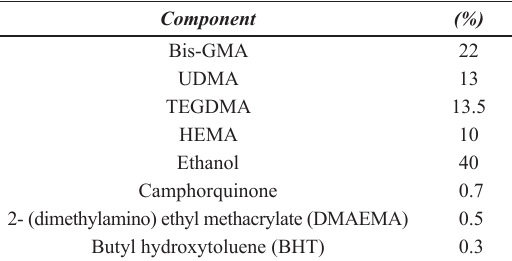
Table 1. Standardized composition of dental adhesives Component